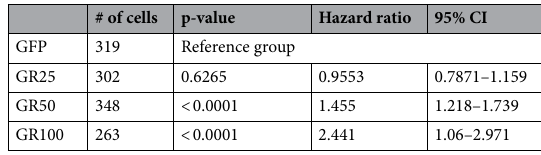
Table 1. Statistical assessment of cortical neuron survival.